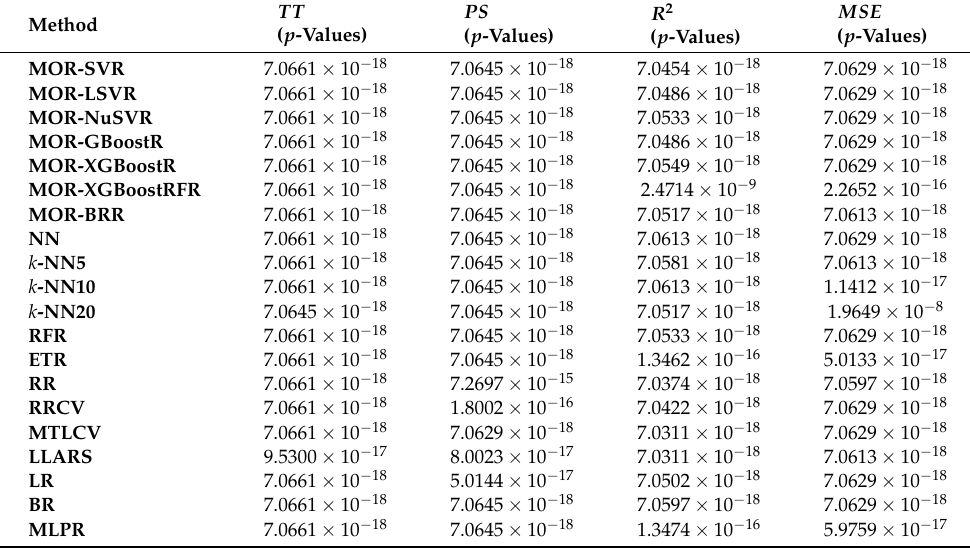
Table 14. Hypothesis test: DTR v other methods (the first stage).